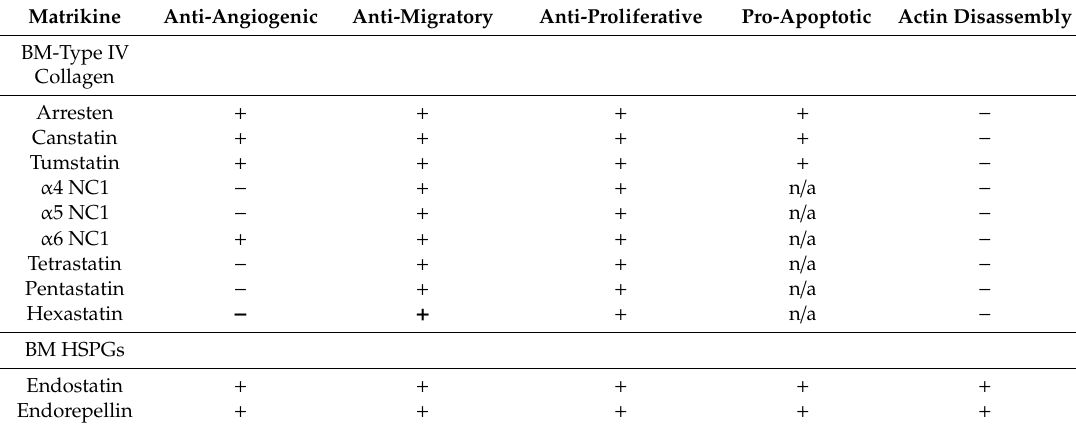
Table 3. Matrikine action on endothelial